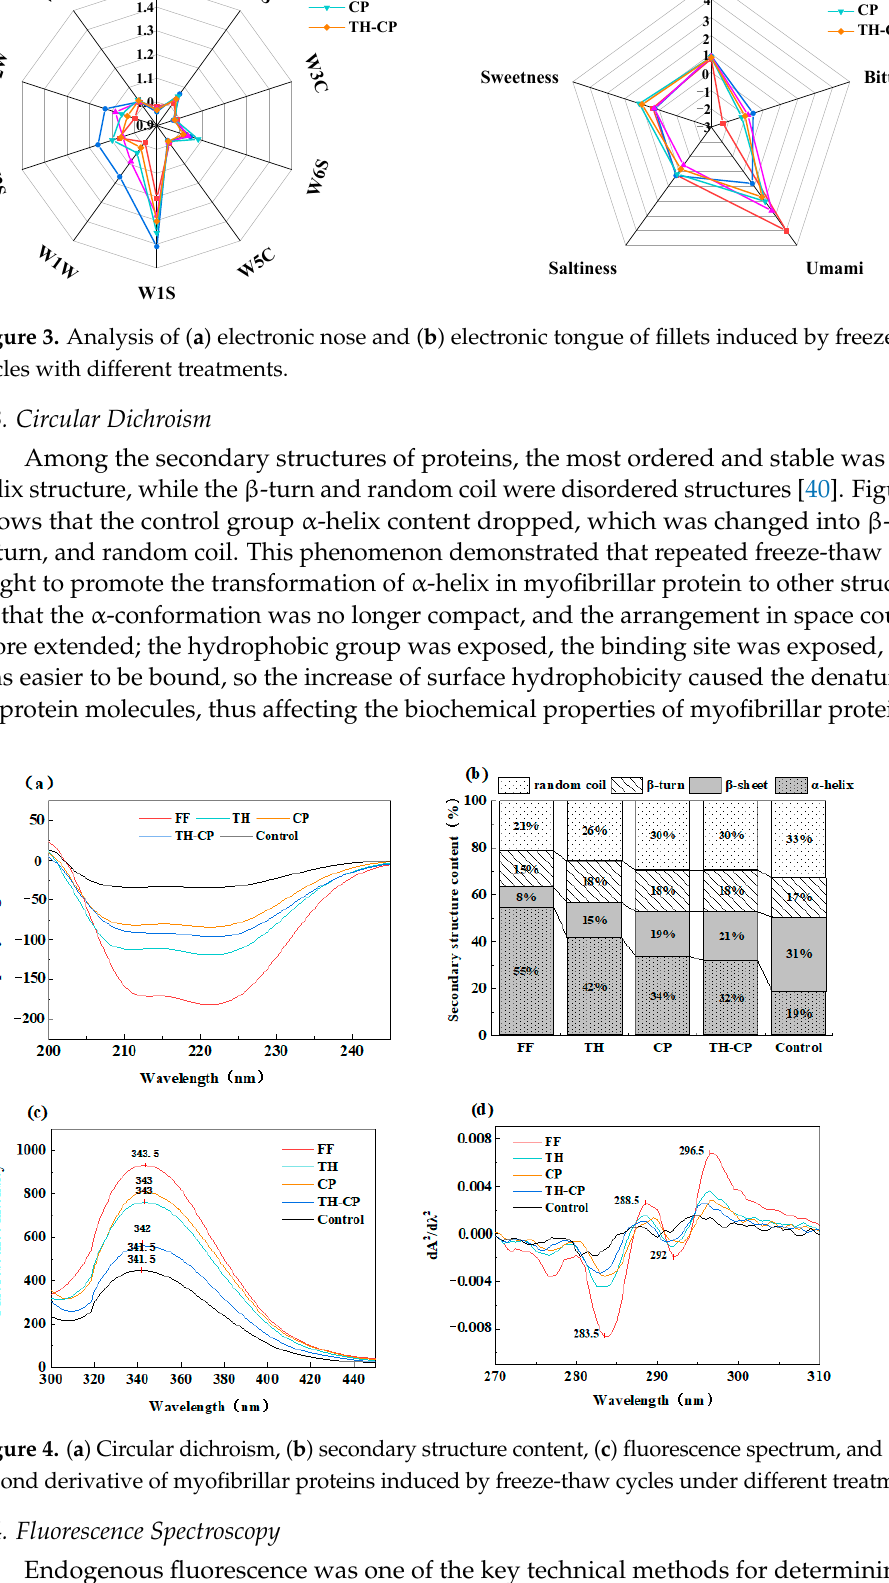
10 of 17 Note: In the significance analysis, the letters from a to z represent the values from large to small, and different letters represent significant differences ( p < 0.05). Similarly, cooking losses were also characterized by the large amounts of heat losses. WHC dropped due to the release of chemically bound water during cooking, which was caused by fat melting and the denaturing of proteins [36]. To reduce cell membrane dam- age, TH had the potential to alter crystal structures and result in smaller ice crystals [37]. The lightness and redness of the sample without peptide or sucrose treatment was signif- icantly decreased. Similarly, the yellowness increased compared with the FF three F-T cy- cles, whereas the addition of peptide or sucrose could better inhibit this deterioration, without significant difference. This phenomenon was most likely caused by cell damage and fluid exudation [38]. Moreover, free radicals caused the crosslink between pigment protein and muscle protein, preventing lipid oxidation [39]. The electronic nose is a specific instrument that can obtain the profile of volatile com-